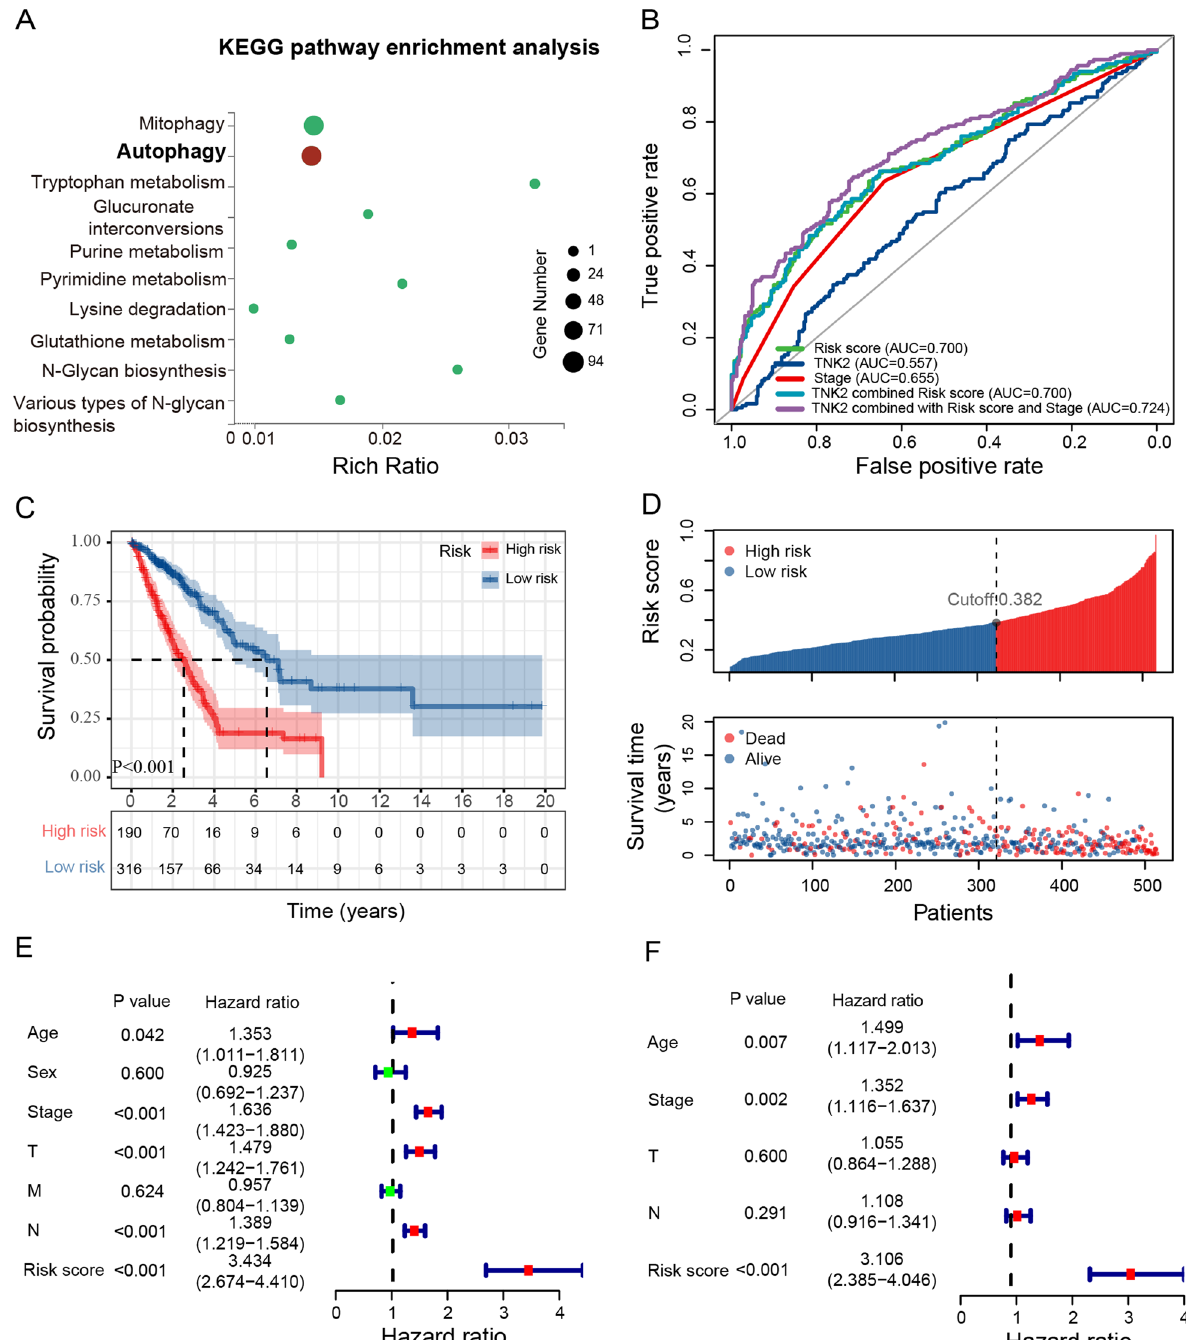
Fig. 1 The association of ACK1 with autophagy and the prognostic accuracy of the risk signature of ACK1-related autophagy genes in the TCGA-LUAD cohort. A RNA-seq was performed to examine RNA expression profilings in shControl and shACK1 A549 cells. Differentially expressed genes were enriched in autophagy. The LASSO regression model was used to identify ACK1-correlated autophagy genes contributing most to prognosis and built the best risk signature in the TCGA-LUAD cohort. B The 5-year ROC curves with the risk score show a higher AUC value than other single risk factors. C The Kaplan–Meier survival curves indicated overall survival for low- and high-risk LUAD patients defined by the risk signature. D The relation between the risk score and survival status of the TCGA-LUAD patients. Forest plots of univariate E and multivariate F Cox regression